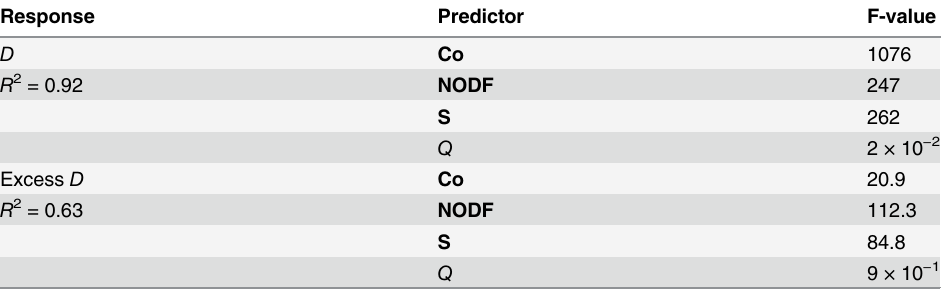
Table 3. Analysis of variance partitioning (ANOVA on linear additive models) of the effects of connec- tance, nestedness, mean specificity, and modularity, on strategy diversity, and the excess strategy di- versity (deviation of empirical values from simulated networks as assessed by the Null Model analysis). Preliminary analyses showed no impact of the interaction type on these relationships, so this factor was not included as a covariate.